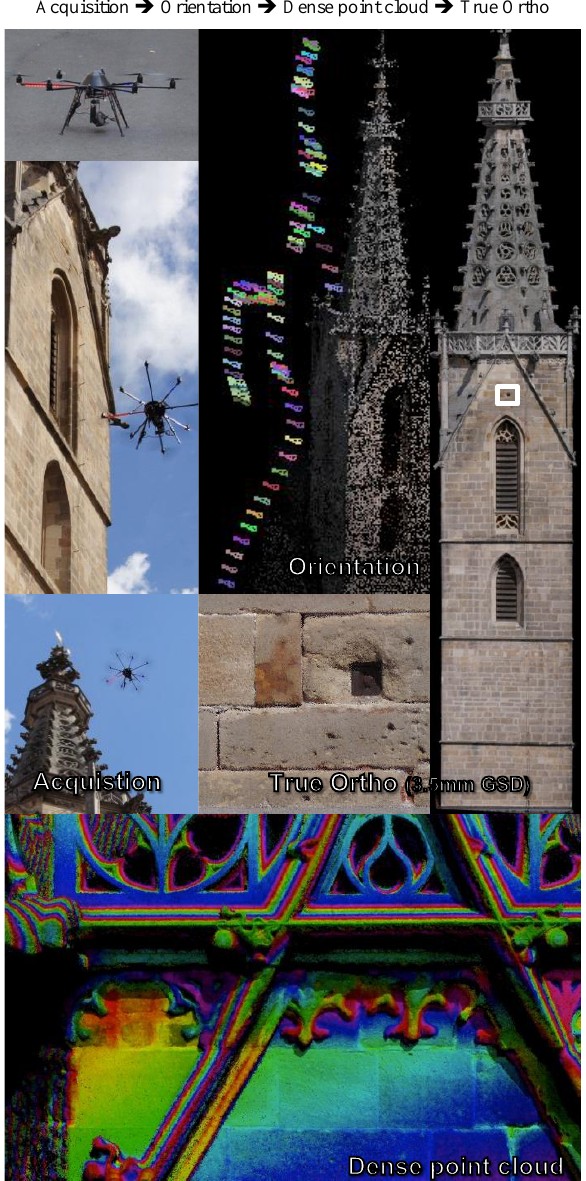
Figure 2: Façade acquisition of a church tower in Rottenburg / Neckar using a UAV. Two images per second were acquired and automatically oriented using Structure from Motion methods . Subsequently, dense image matching was used to generate point clouds and true orthophotos